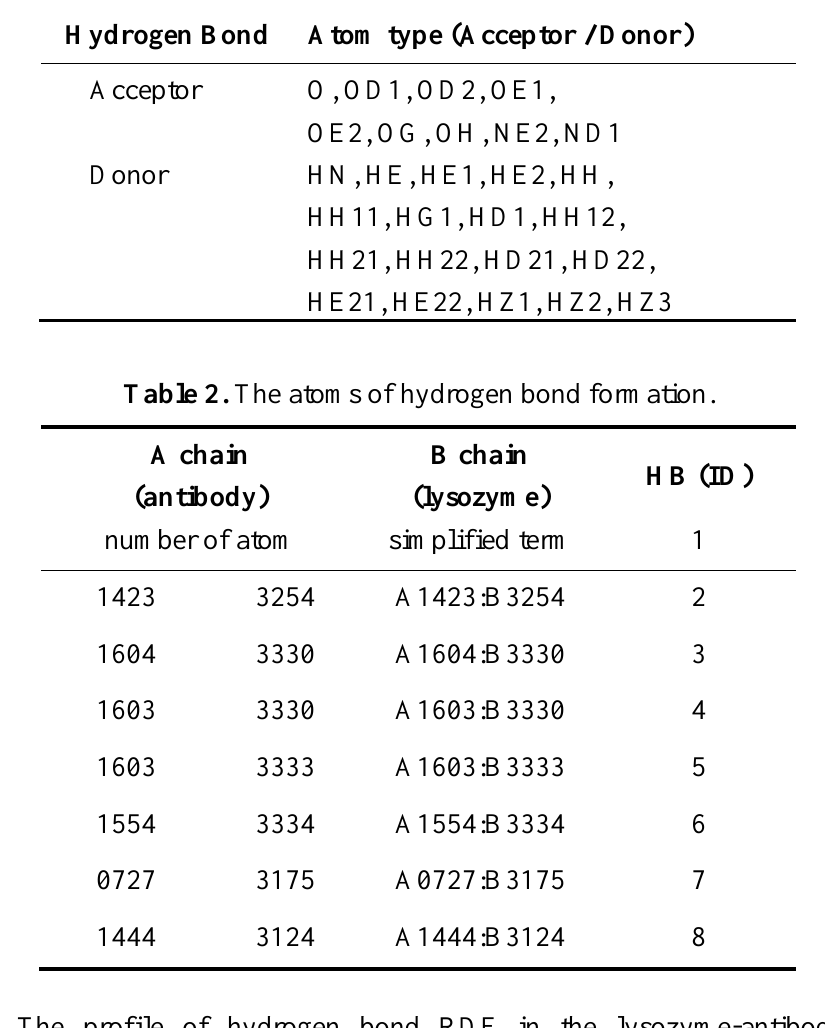
Figure 2. The profile of hydrogen bond RDF in the lysozyme-antibody complex simulation